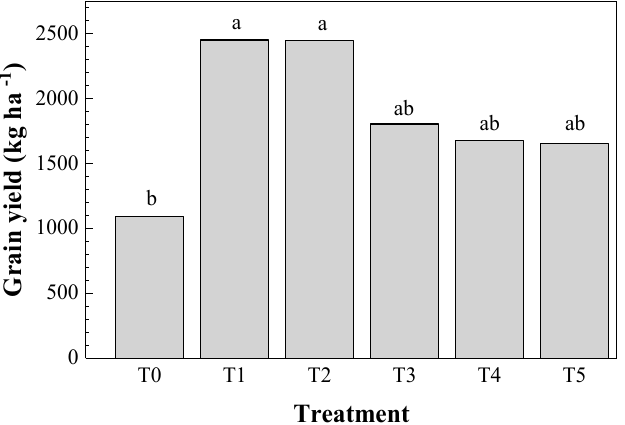
Figure 2. Average barley grain yield for each treatment throughout the three-year period. Treatments labelled with the same lowercase letters were not significantly different at p < 0.05 using Tukey’s test. Average barley grain yields were 1150 kg · ha − 1 for the unfertilized control (T0), varied between 1650 and 1800 kg · ha − 1 for the DPM treatments (T3–T5) and reached 2450 kg · ha − 1 for the mineral fertilizer treatments (T1 and T2). In these latter cases, production was increased by 124% as compared to the control, while organic fertilizers led to an increase ranging from 51% (for T5) to 65% (for T3). This is in line with the findings of other studies [14,32], in which mineral fertilization also had a greater impact on crop yield and N